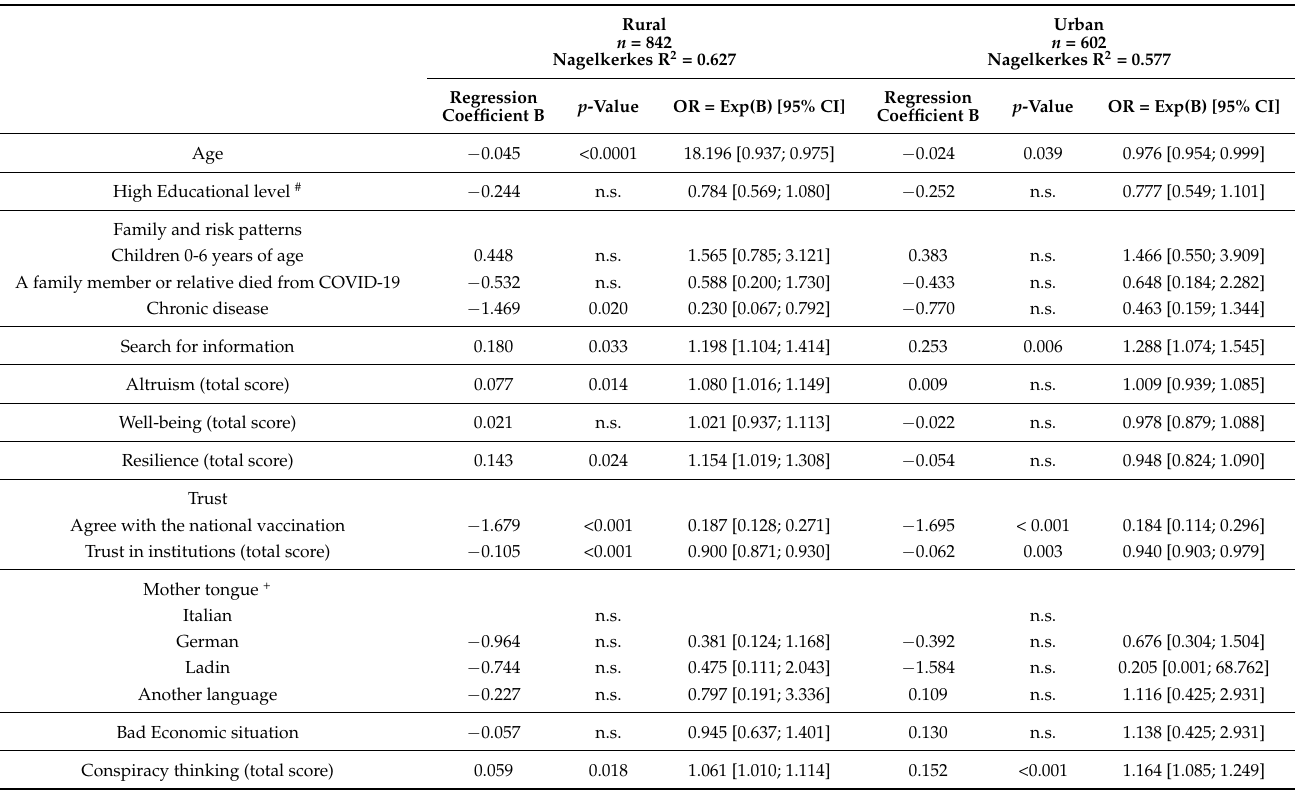
Table 2. Predictors of vaccination hesitancy in South Tyrol, Italy in March 2021 in multivariate logistic regression